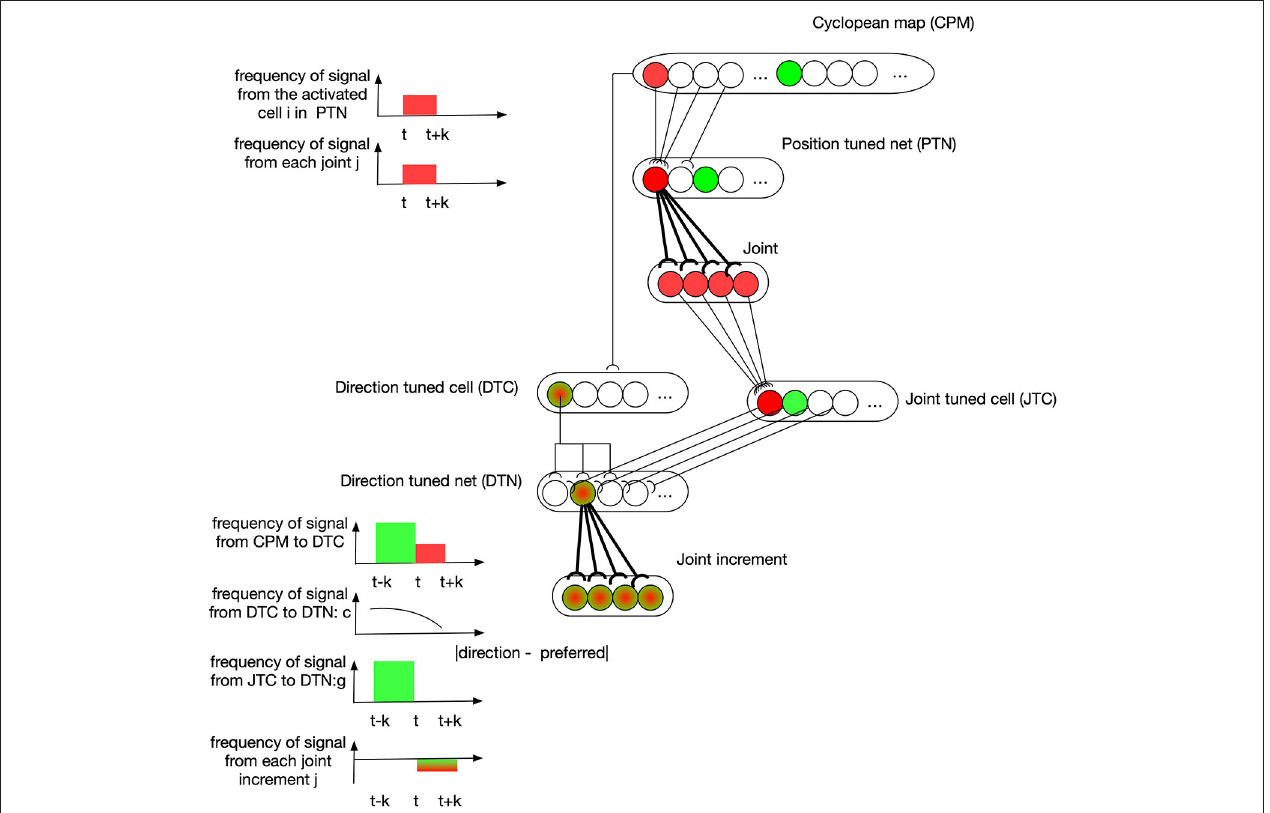
FIGURE 4 | Position controller: learning of neural networks. At the time t-k, the visual information of the end-effector activates the green cell in the CPM. Then the end-effector is moved to another position represented by the red cell in CPM at time t. A cell in PTN down-samples the CPM by selectively receiving signals from a group of spatially-neighboring neurons in the CPM. At the same time, the state of arm joints stays in response to the red PTN cell, and this simultaneous activation of both PTN cell and joint cell strengthens the synapses between them through associative-learning rules (bolded connections between PTN and joint neurons in the figure). In the subsequent motion of the end-effector, the direction of motion is captured by some DTC cells, as shown by a green-red cell for example, because this direction lies in their receptive fields. Their discharges are dependent on the angular difference between their preferred direction and the perceived direction. A cell in DTN receives two signals, one from a DTC and the other from a JTC, leading to a selective tuning for a specific joint configuration. The number of cells in DTN equals the product of the number of cells in DTC and JTC so that DTN captures all possible situations. A DTN cell’s discharge is equal to the multiplication of two signals it receives. At time t, DTN cells receive JTC’s signals in green state and the DTC signals capturing the end-effector’s motion direction. The synapses between activated DTN cells and the joint increments resulting in this motion are then learned